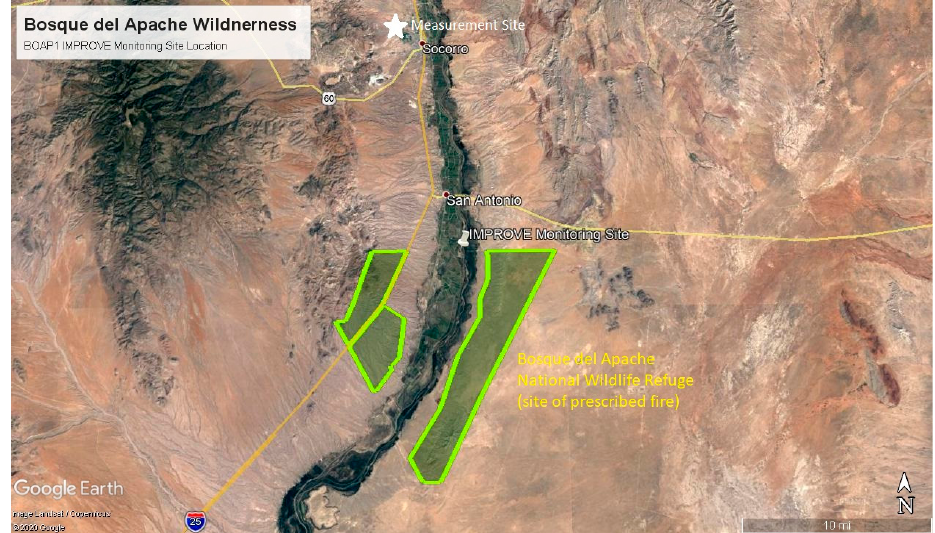
Figure 1. Location of the Bosque del Apache National Wilderness National Wildlife Refuge is demarcated in green in relation to the receptor site in Socorro, NM (Google Earth). The Interagency Monitoring of Protected Visual Environments (IMPROVE) air quality monitoring station (BOAP1) is also shown.